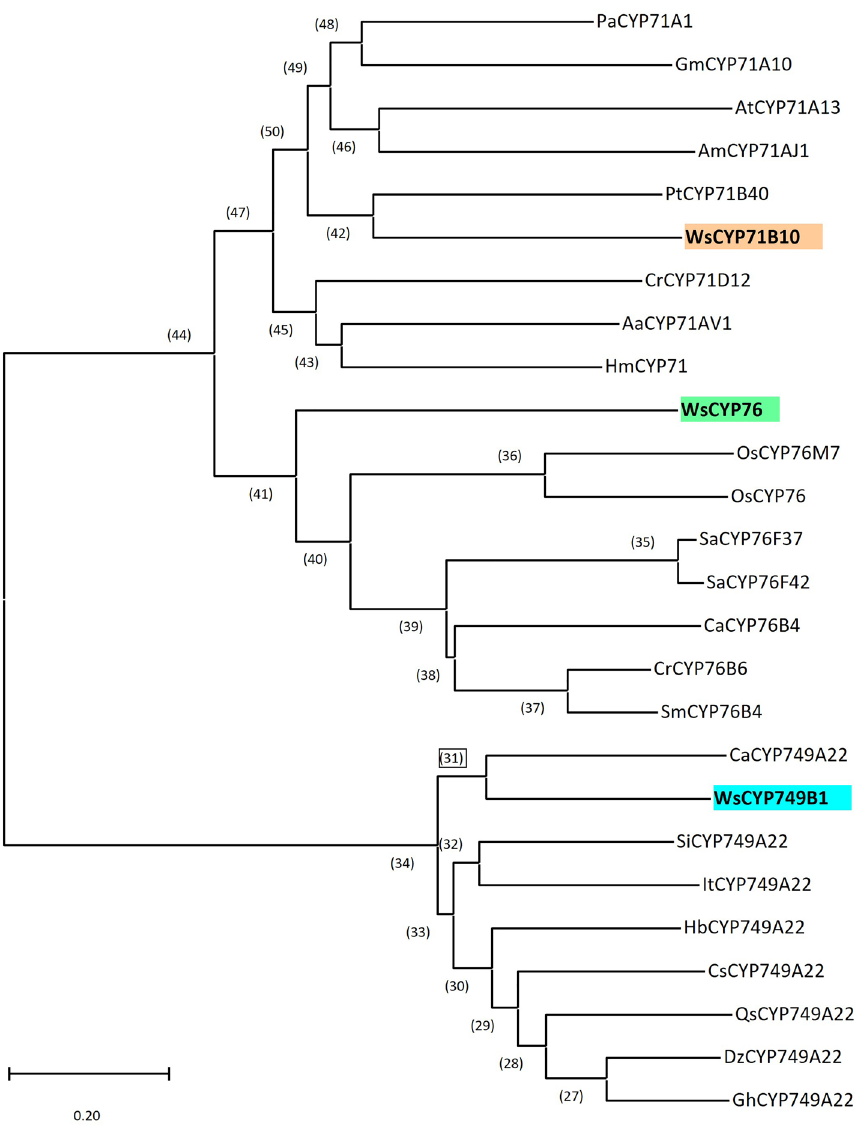
Figure 2. Phylogenetic relationship of WsCYP450s with other plant CYP450s involved in the plant metabolism. The tree was constructed using MEGA v.6, and the statistical reliability of individual nodes of the tree was assessed by bootstrap analyses with 1000 replicates. GenBank accessions of protein sequences used in the tree are listed in Table